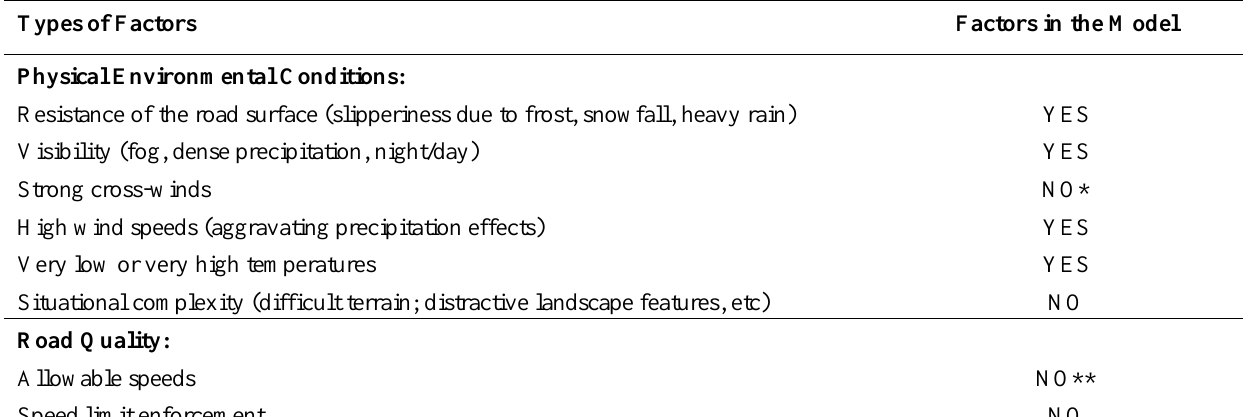
Table 1. Types of factors influencing crash frequency and factors included in the model. Types of Factors Factors in the